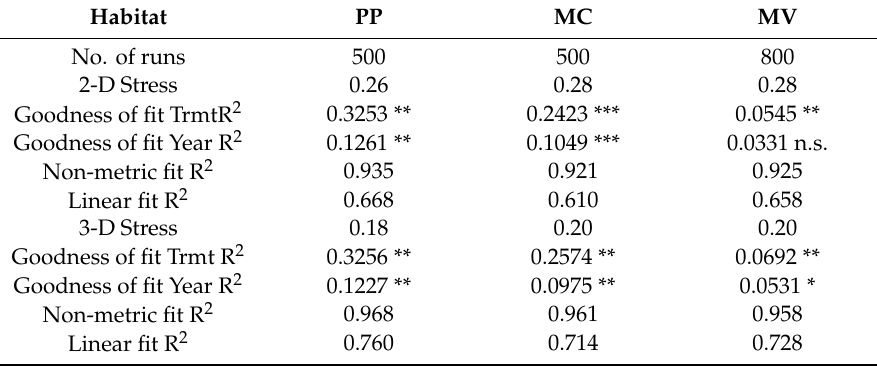
Table 2. Non-metric multidimensional scaling (NMDS) results for ponderosa pine forest (PP), mixed-conifer forest (MC), and mountain valley grassland (MV) at the Valles Caldera National Preserve by treatment (burned / unburned) and years. Significance values: * 0.05 > p > 0.01, ** 0.01 > p > 0.001, *** p = 0.001, n.s. not